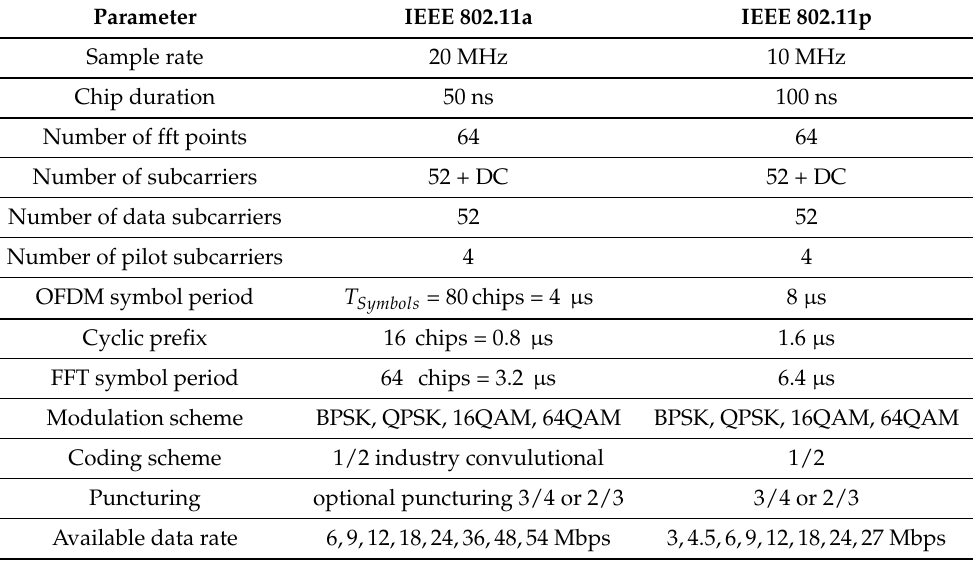
Table 4. Differences between IEEE 802.11a and IEEE